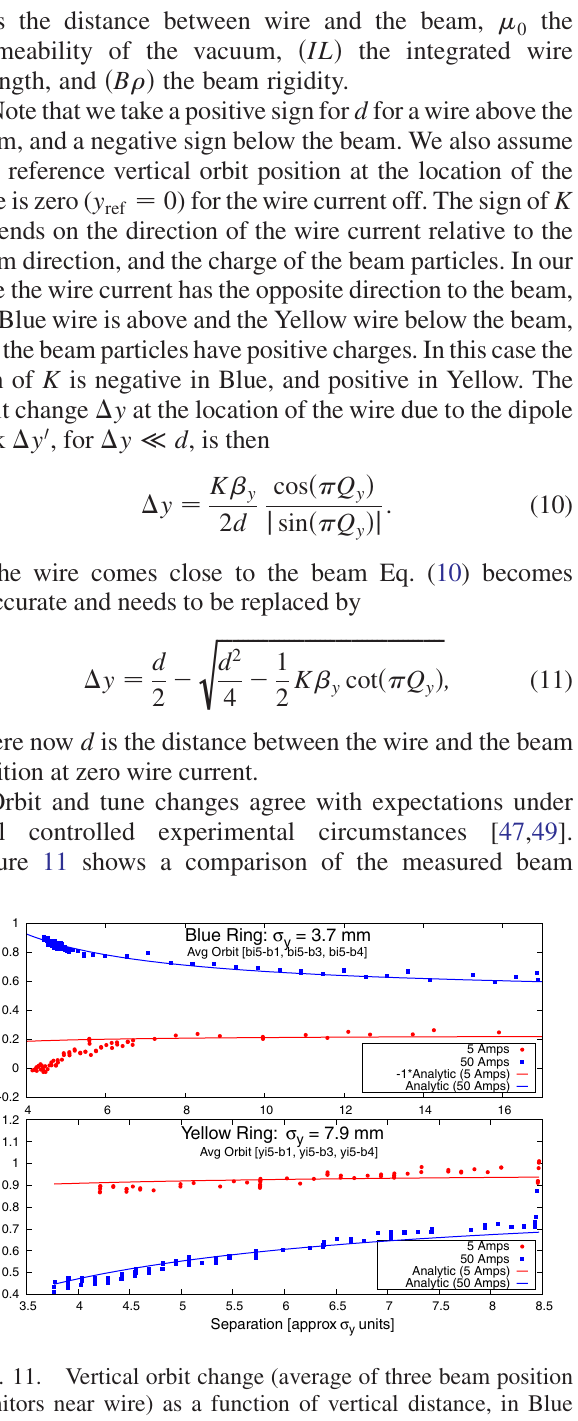
FIG. 11. Vertical orbit change (average of three beam position monitors near wire) as a function of vertical distance, in Blue and Yellow ring at 5 A and 50 A. Solid lines in all plots represent the analytical